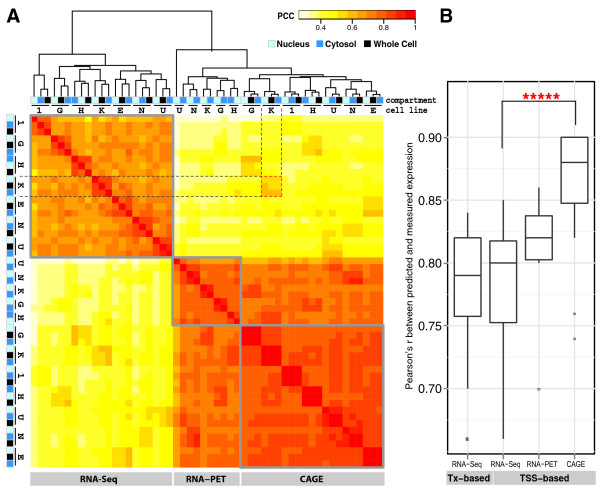
Comparison of expression quantification methods. (a) Heatmap of correlations between PolyA+ experiments from various cell lines and cell compartments. Experiments from the same expression quantification methods tend to cluster together, and CAGE and RNA-PET are closer to each other than they are to RNA-Seq. The clustering tree also shows that experiments on different cell compartments in the same cell line tend to group together and RNA expression from the cytosol (blue) and whole cell (black) tend to group together rather than with that of the nucleus (light blue). Code for cell lines: K, K562; G, GM12878; 1, H1-hESC; H, HepG2; E, HeLa-S3; N, NHEK; U, HUVEC. (b) Boxplot of correlation coefficients for all expression prediction in CAGE, RNA-PET, and RNA-Seq categories. Paired Wilcoxon test shows that CAGE-based expression data are significantly better predicted than RNA-Seq-based expression data (P-value = 3 × 10-5).